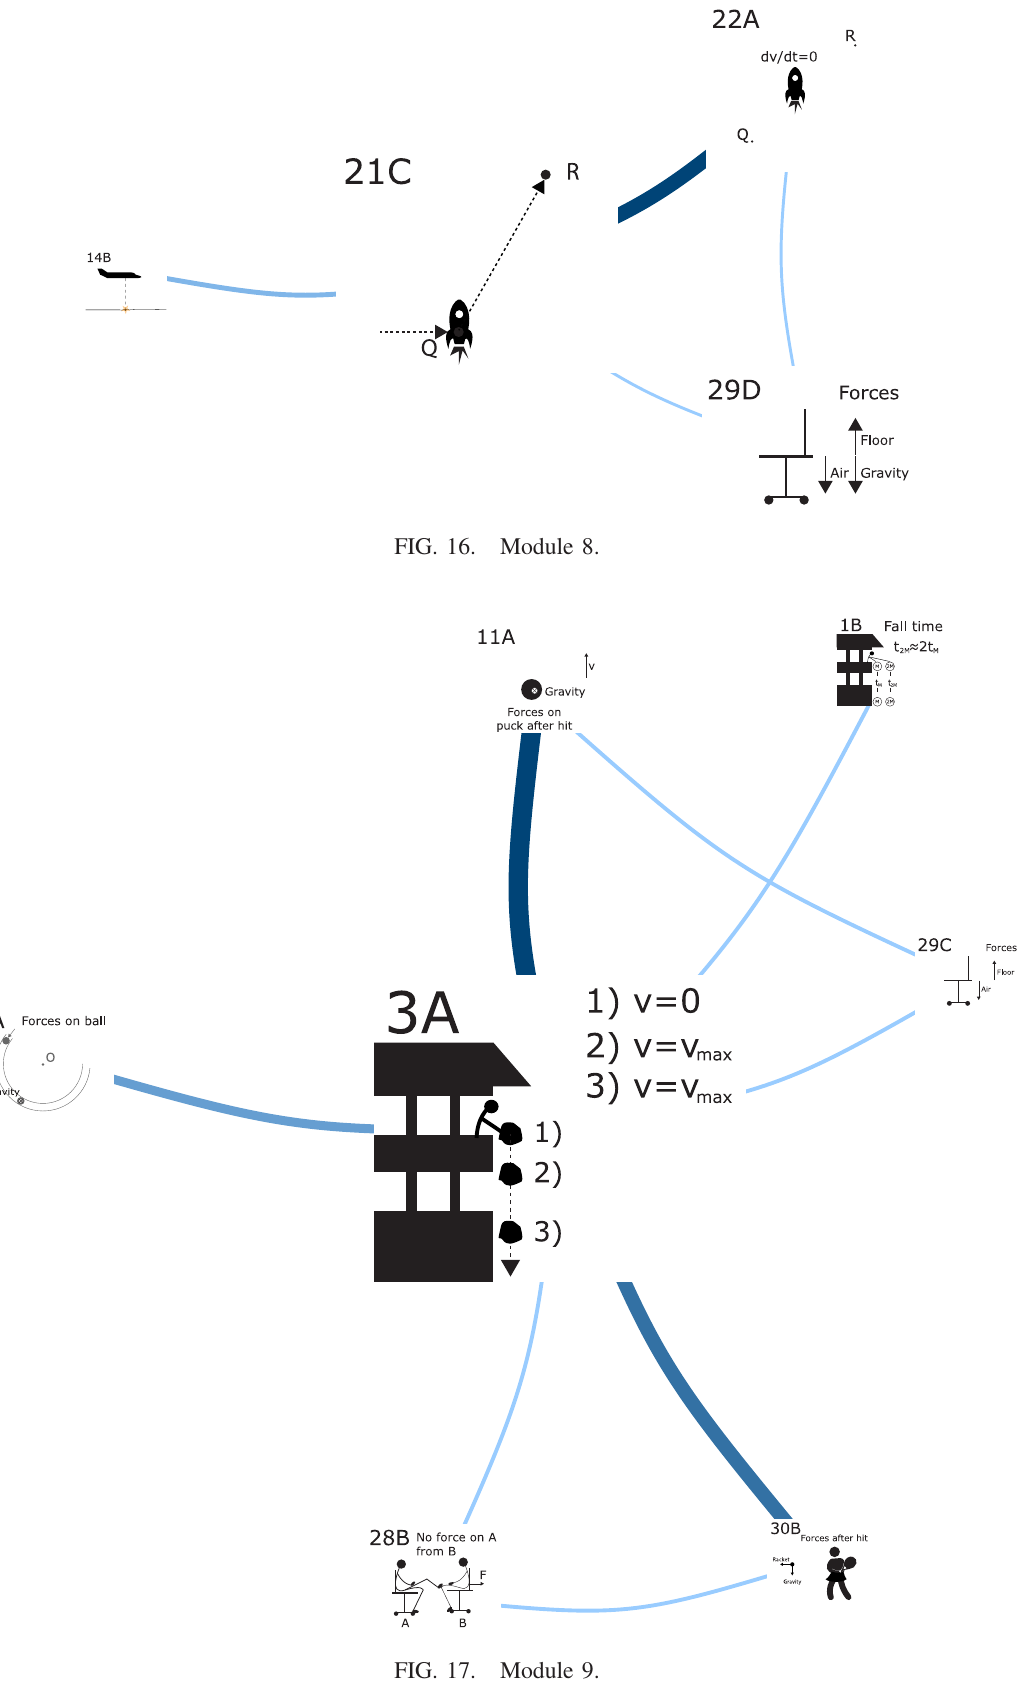
FIG. 16. Module 8.